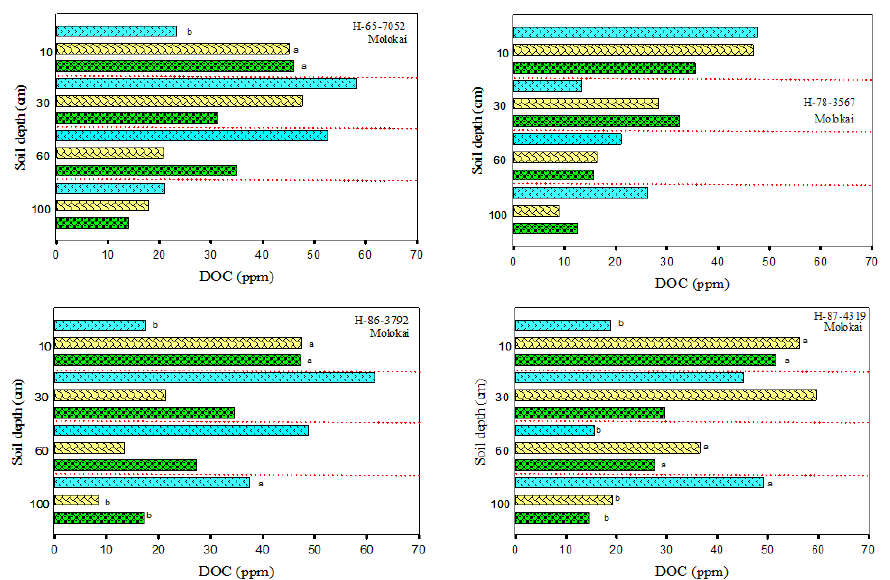
Figure 4. Dissolved organic carbon (DOC) in Molokai soils. Color represents sugarcane growing stages ( i.e. , blue-tillering, yellow-grand growth, green-maturity) when the soil samples were collected. Means followed by the same letter or no letters for the bars in each soil depth are not significantly different Tukey’s test at Pr <